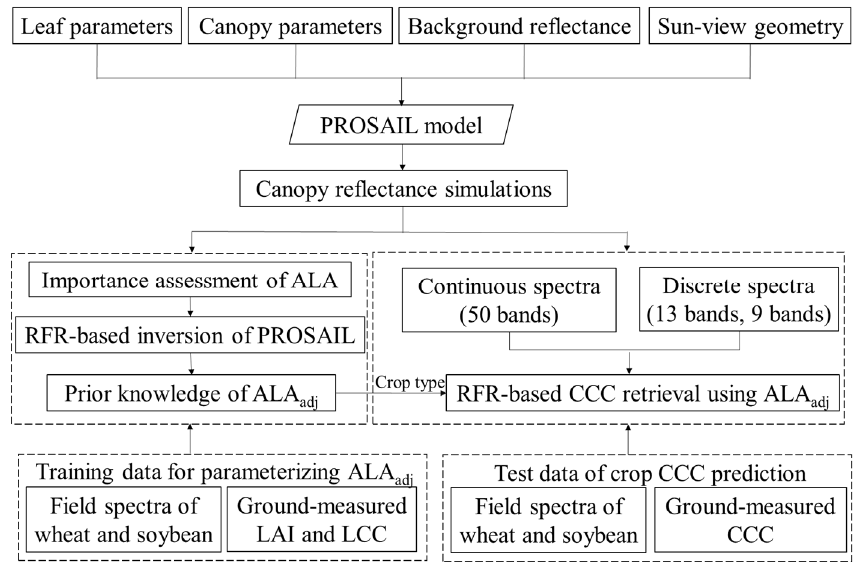
Figure 1. Workflow of crop canopy chlorophyll content (CCC) retrieval and validation methods used in the present study. The prior knowledge of an adjusted average leaf angle (ALA adj ) is involved in the PROSAIL-based CCC retrieval model using the random forest regression (RFR) algorithm.